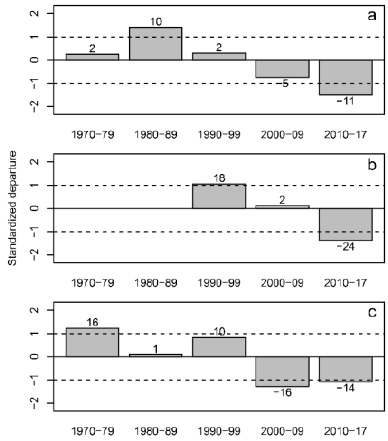
Figure 6. Decadal departure of river discharge from ( a ) headwater, ( b ) upper and ( c ) entire Bagmati catchments. Note: labels associated to the bars represent percentage of departure in relation to long- term mean.